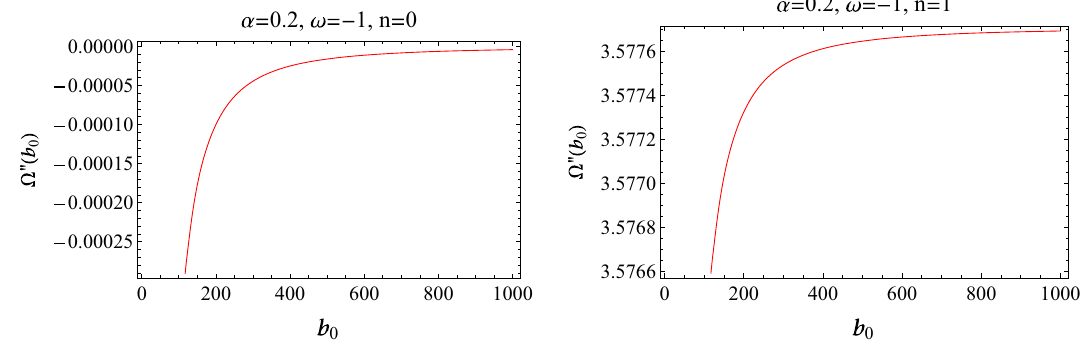
Fig. 4 Stability of thin-shell gravastars with generalized Chaplygin gas EoS with different values of n . For ω = − 1, the left plot shows unstable behavior for n = 0 and right plot expresses the stable structure for n = 1